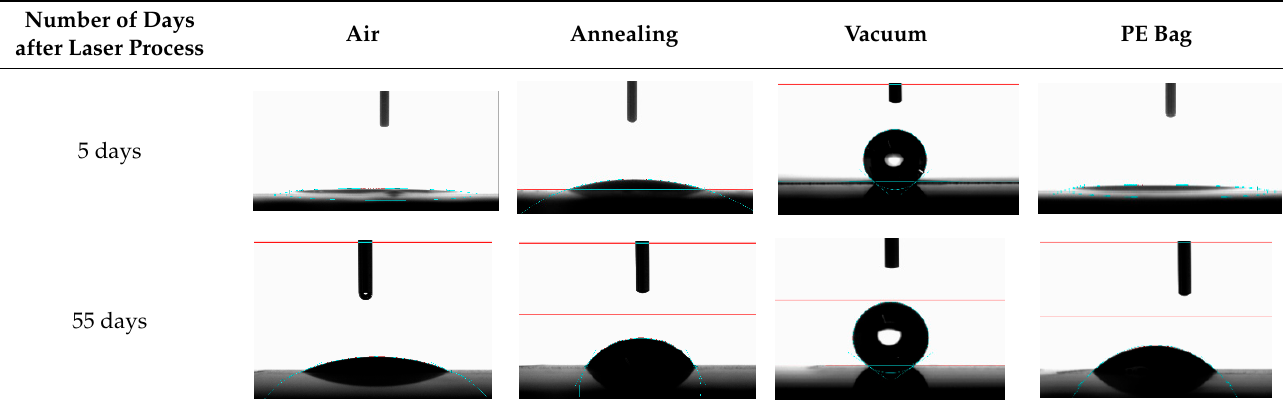
Figure 5. Time dependency of static contact angle for structure A and four types of post-processing. Observed contact angles for five and 55 days are in Table 5. In this table can be clearly seen an effect of the vacuum post-processing on the creation of the hydrophobic state. Table 5. Comparison of droplet images for structure A after 5 and 55 days.